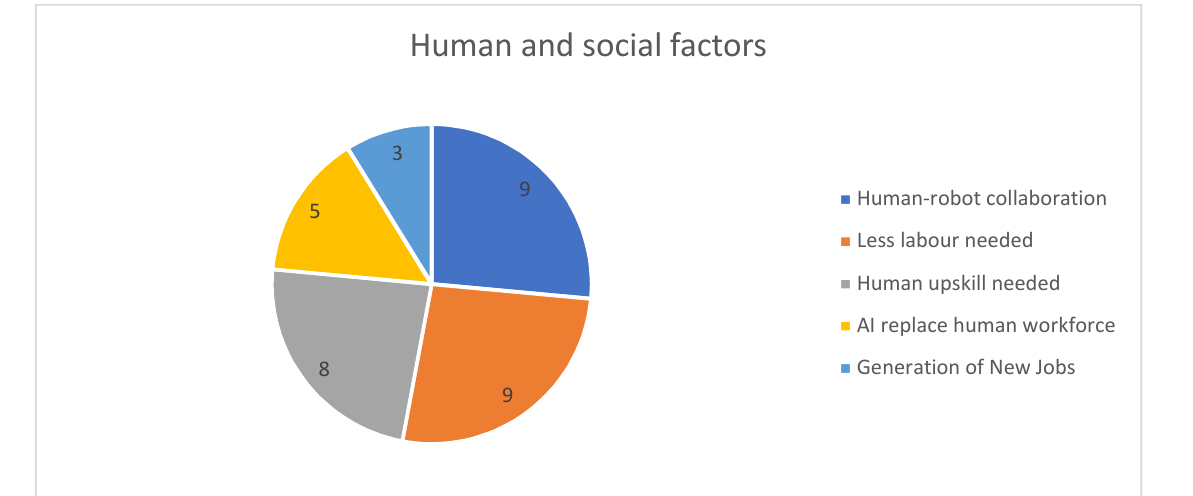
Figure 8. Overview of human and social factors mentioned in SLRs.